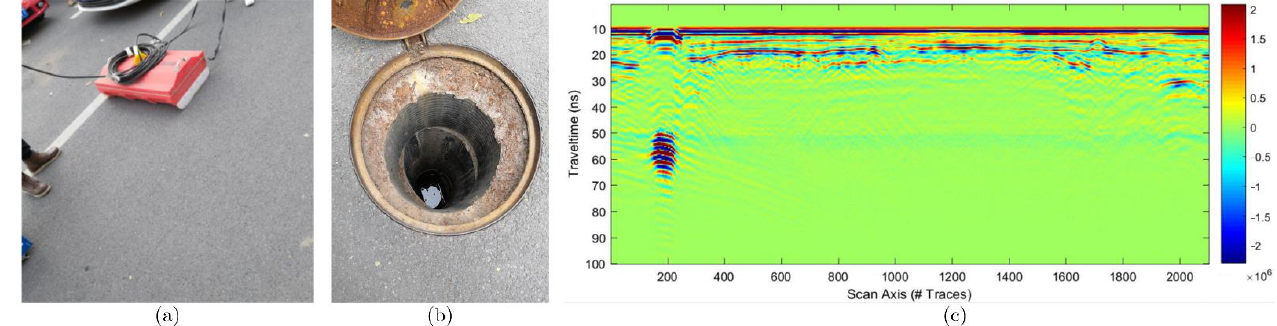
Figure 16. GPR field data collection. ( a ) LAUREL radar physical picture; ( b ) the rainwater pipe under the manhole cover; ( c ) GPR B-SCAN image.